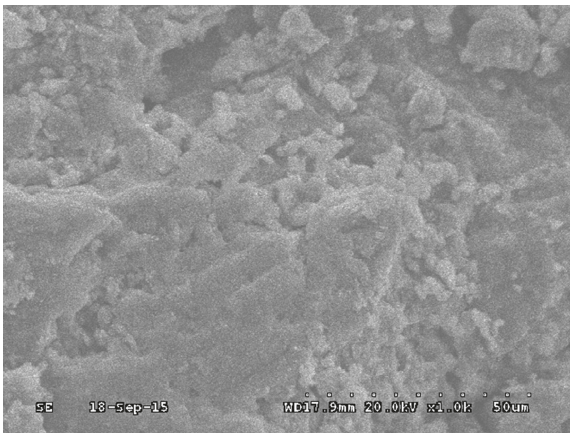
Figure 5: Microstructural feature of Pb-5000 mg/kg contaminated soils stabilized by 15% cement under 7 freeze-thaw